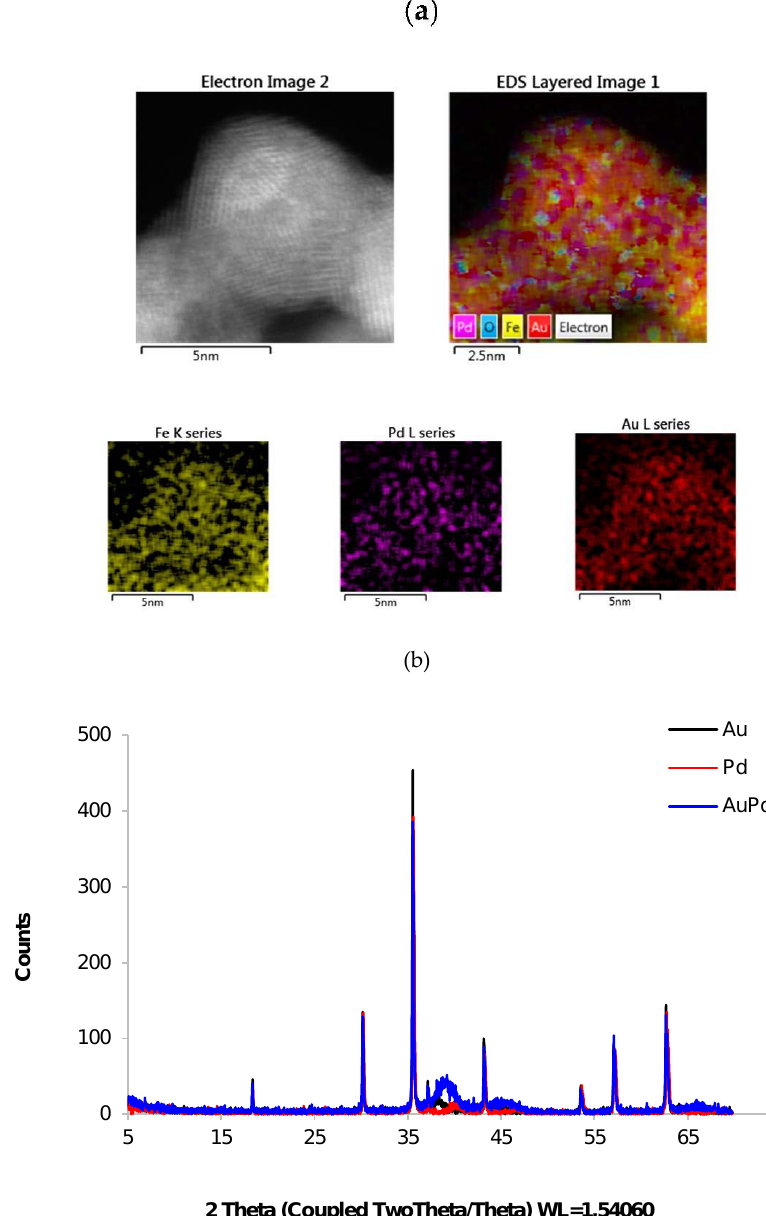
Figure 2. ( a ) STEM-EDS image and ( b ) XRD data of AuPd–Fe 3 O 4 catalyst.